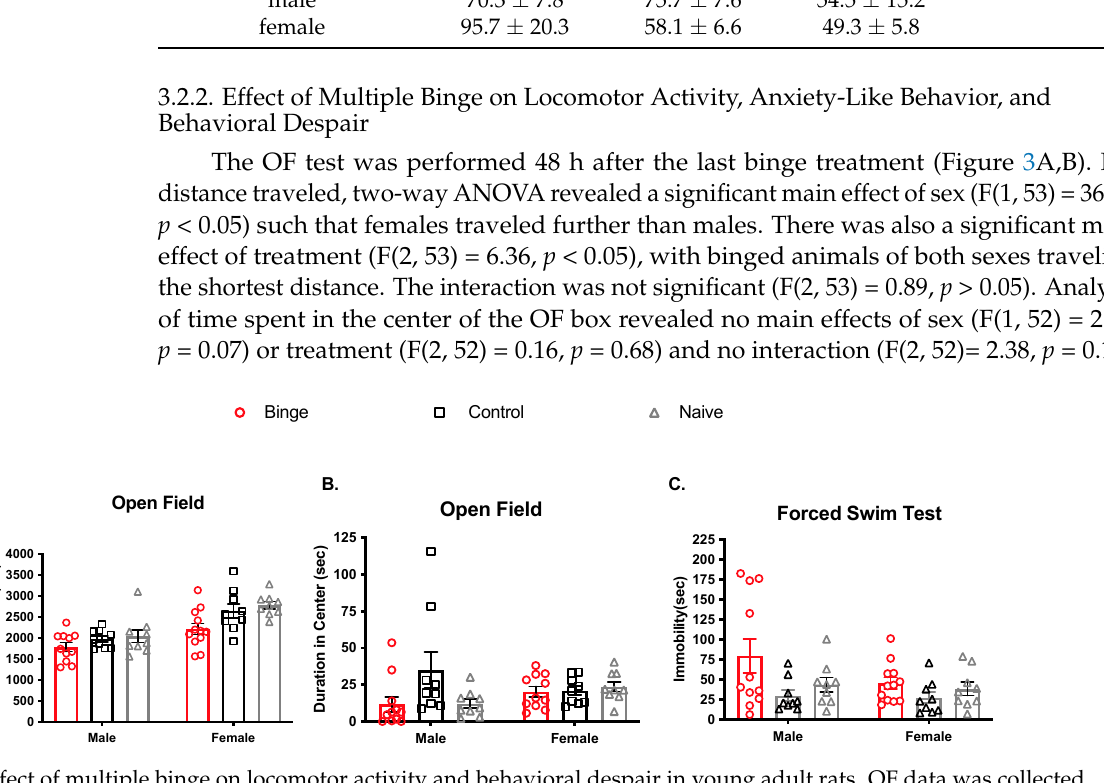
Figure 4. Effect of repeated binge exposure on anxiety-like behavior in males and females . Although there were no signif- icant differences in % time in the center ( A ), binged animals of both sexes made the fewest head entries into the center ( D ). Females spent more % time ( B ) and made more head entries into the open arms ( E ), but there were no effects of binge. For the closed arms, males spent more time there compared to females ( C ). Females made more head entries into the closed arms ( F ) compared to males. Bars represent ± SEM from 9–12 subjects per group. 3.2.3. Effects of Repeated Binge on the Antioxidant Capacity of the Brain The PFC plays a role in affect-related functions and is highly innervated from brain regions responsible for mood, learning, and memory [56]. To determine if the PFC is sus- ceptible to changes in antioxidant activity from repeated binge alcohol exposure, we measured GSH levels and GR, GPx, and GST antioxidant enzyme activities (Figure 5). Percent values were calculated by dividing antioxidant concentrations from average naïve